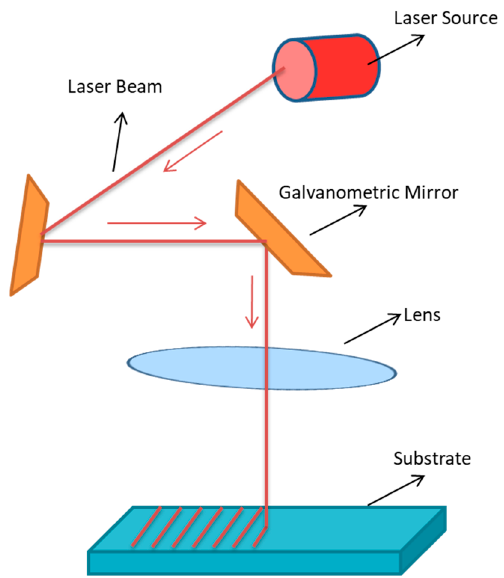
Figure 19. Diagrammatic representation of a substrate undergoing laser treatment and the major components involved in this process. In this process, rays from laser sources hit the galvanometric mirror, followed by lens, and then on the substrate.